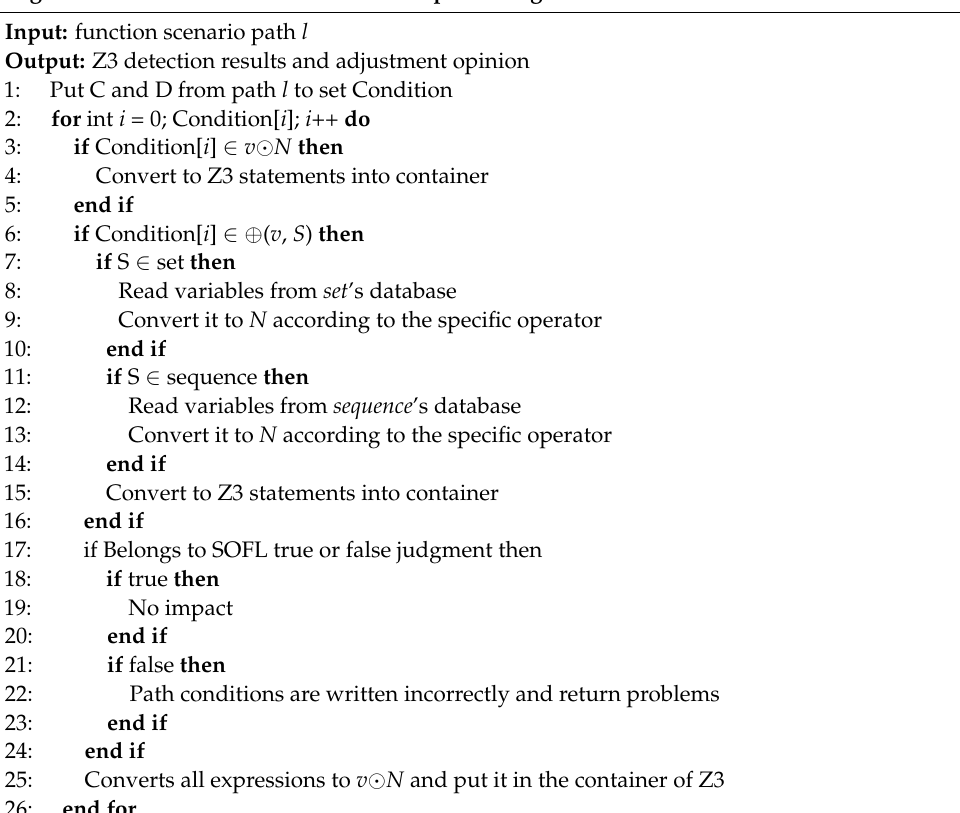
Algorithm 3: Condition classification and